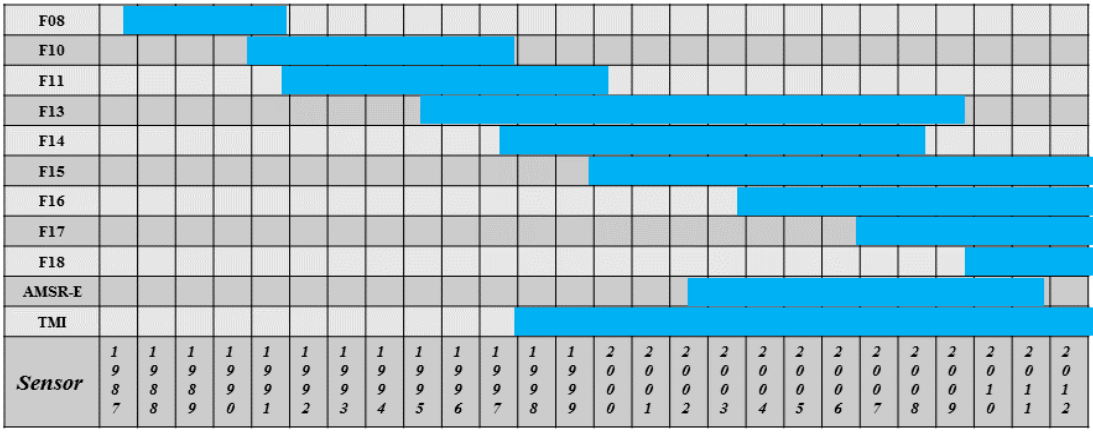
Figure 1. Chart of all satellite passive microwave (PMW) sensors during 1987–2012 used in the Naval Research Laboratory (NRL) Tropical Cyclone (TC) database.